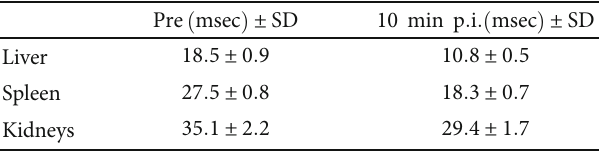
Figure 1: Radio TLC of [ 99m Tc]TcMDP- Fe CaPs on ITLC-SG chromatography paper with saline (0.9% v / v ) as eluent. Table 1: Prescan and 10min p.i.